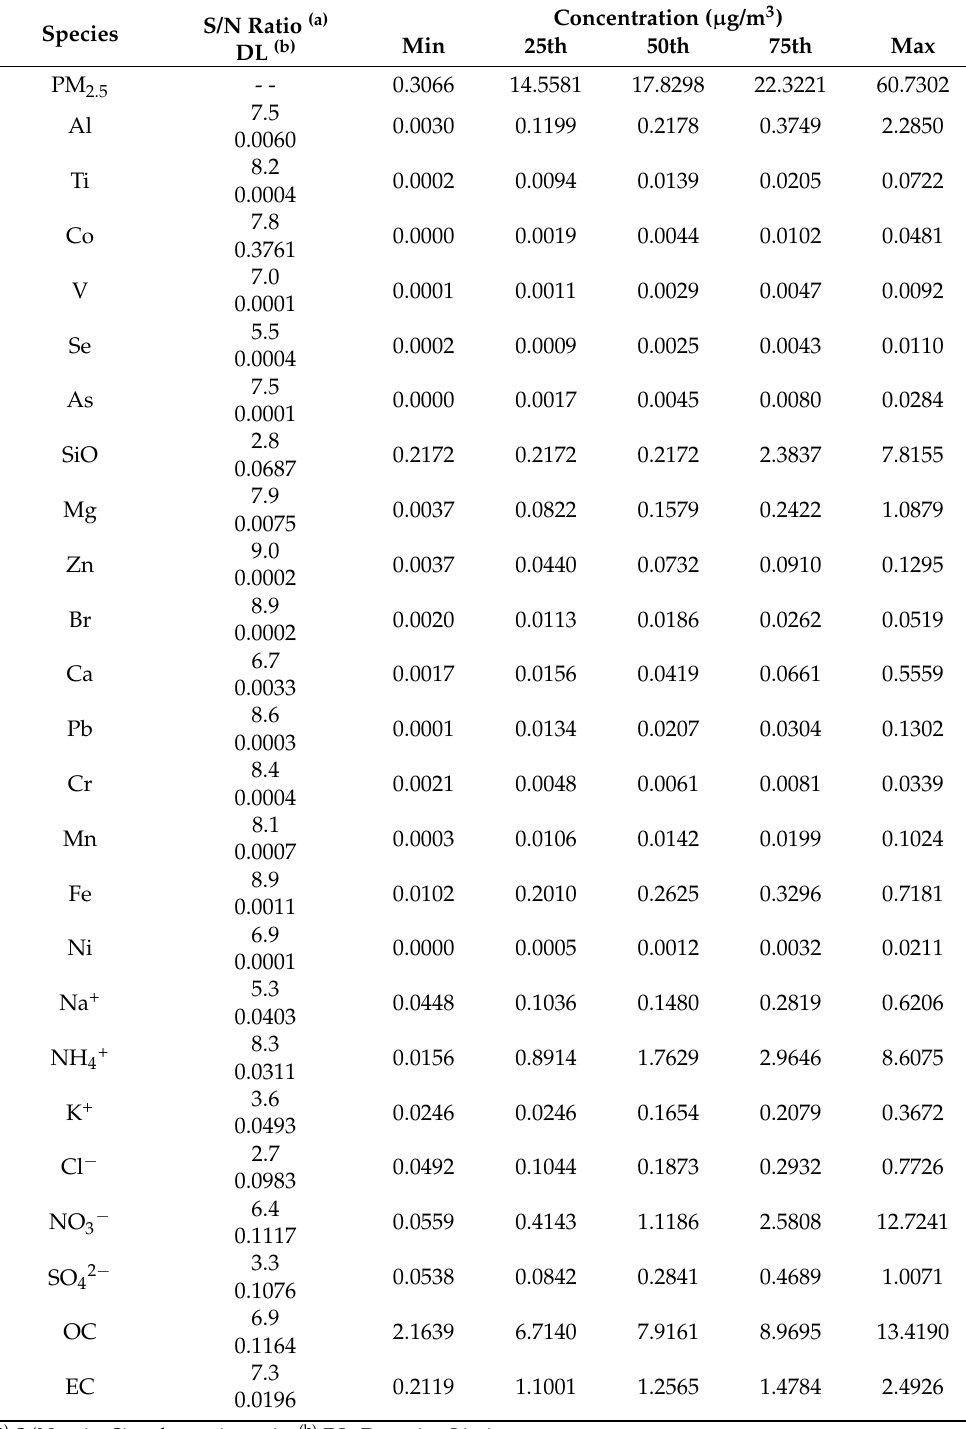
Table 2. Summary of PM 2.5 concentrations and the concentrations of 25 chemical species used for PMF